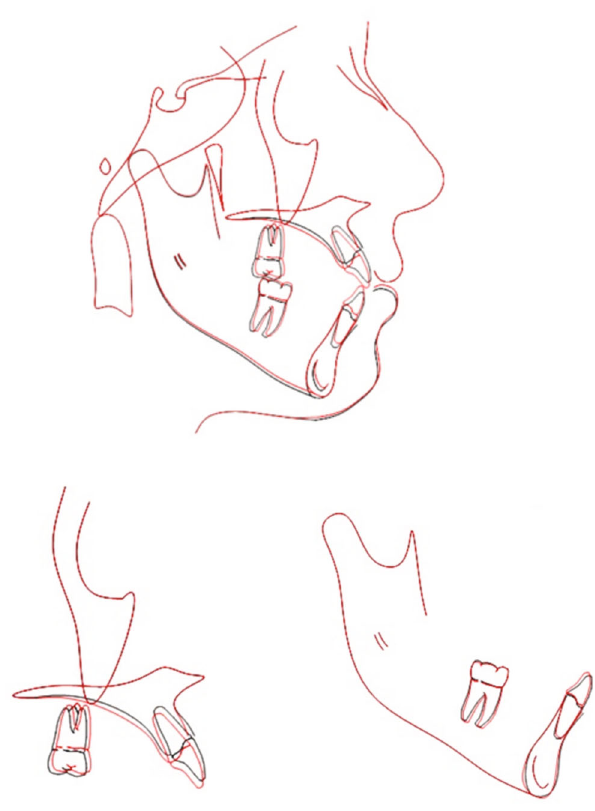
Figure 9: Posttreatment cephalometric